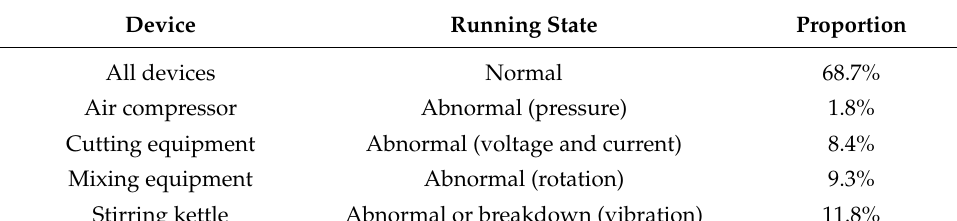
Table 3. The possible state of each device in A-class insulation panel production line (Original dataset).